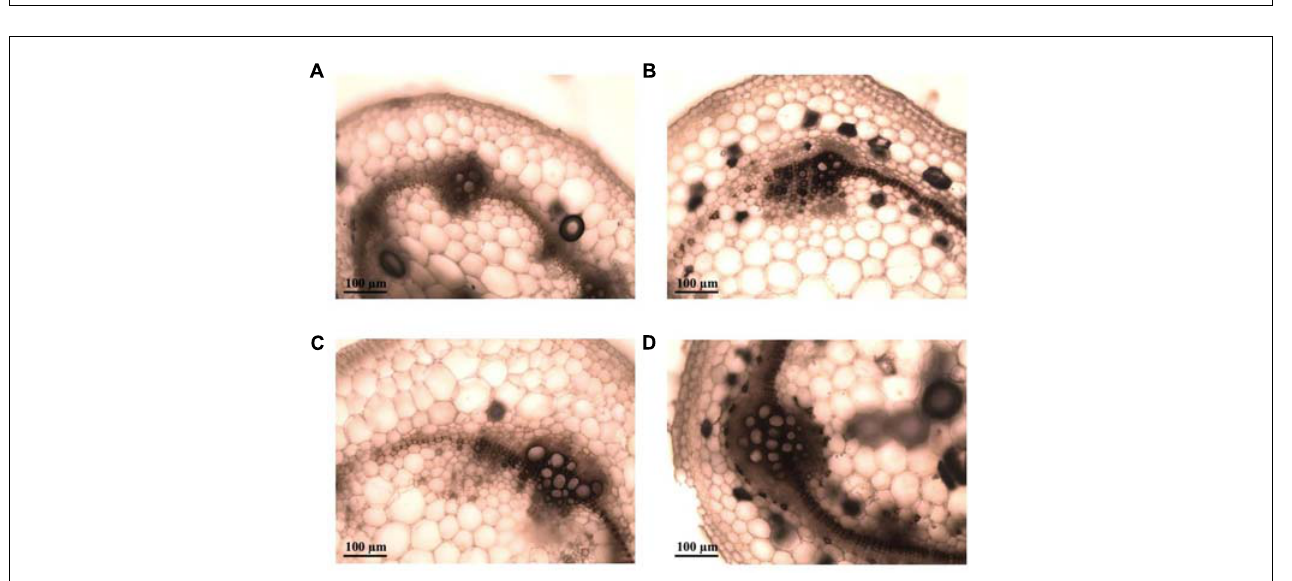
FIGURE 7 | Representative fluorescense (GFP) micrographs of aniline blue stained stem cross-sections of plants from the susceptible potato cultivar S. tuberosum cv. Chieftain and the tolerant clone 09509.6. Callose deposition was detected as yellow fluorescence zones (white arrows) 2 days after stem inoculation with R. solanacearum UY031 strain and compared to mock inoculated plants. (A) Chieftain plant inoculated with R. solanacearum. (B) Mock inoculated 09509.6 plant. (C) Xylem vessels of Chieftain plant inoculated with R. solanacearum. (D) 09509.6 plant inoculated with R. solanacearum . (E) Cortical parenchyma of Chieftain plant inoculated with R. solanacearum. (F) Internal phloem tissue of tolerant potato genotype 09509.6 inoculated with R. solanacearum.